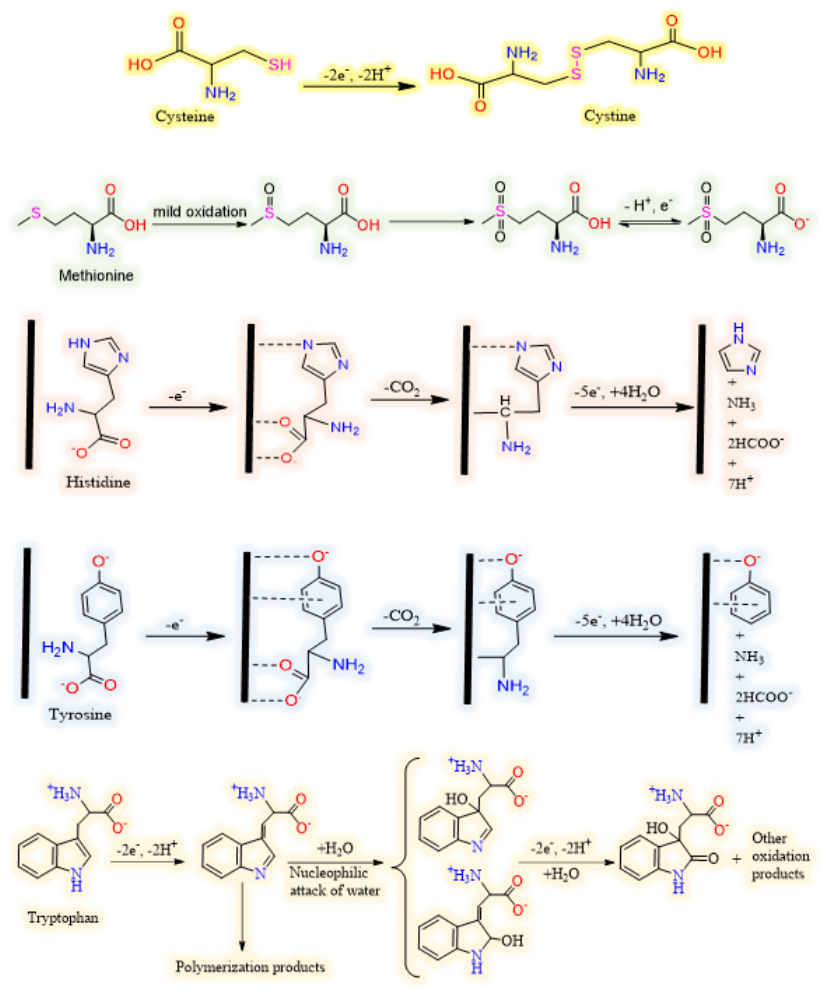
Figure 4. Schematic representations of typical electrooxidation pathway for cysteine, methionine, histidine, tyrosine and tryptophan (from up to down,